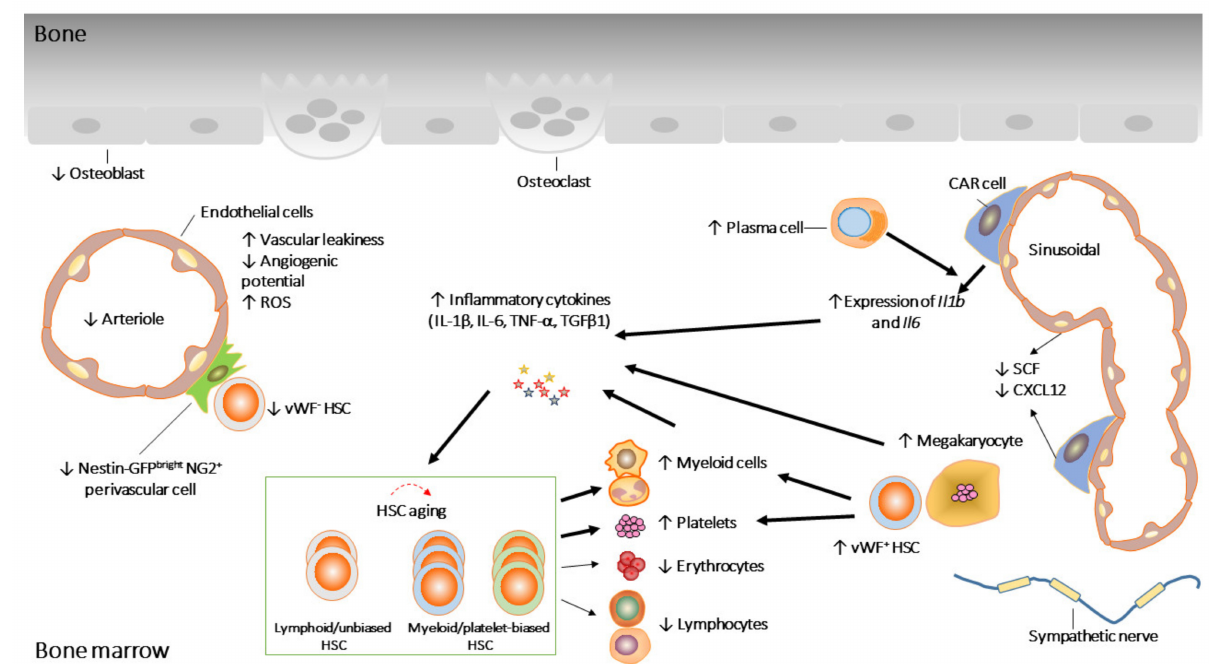
Figure 1. Age-associated changes in HSCs and their niche. Aged HSCs, with reduced repopulation potential, are dominated by myeloid/platelet-biased HSCs. HSCs’ age-associated defects are partially the consequences of age-associated changes in the niche. ↓ and ↑ represent increased and decreased activity,